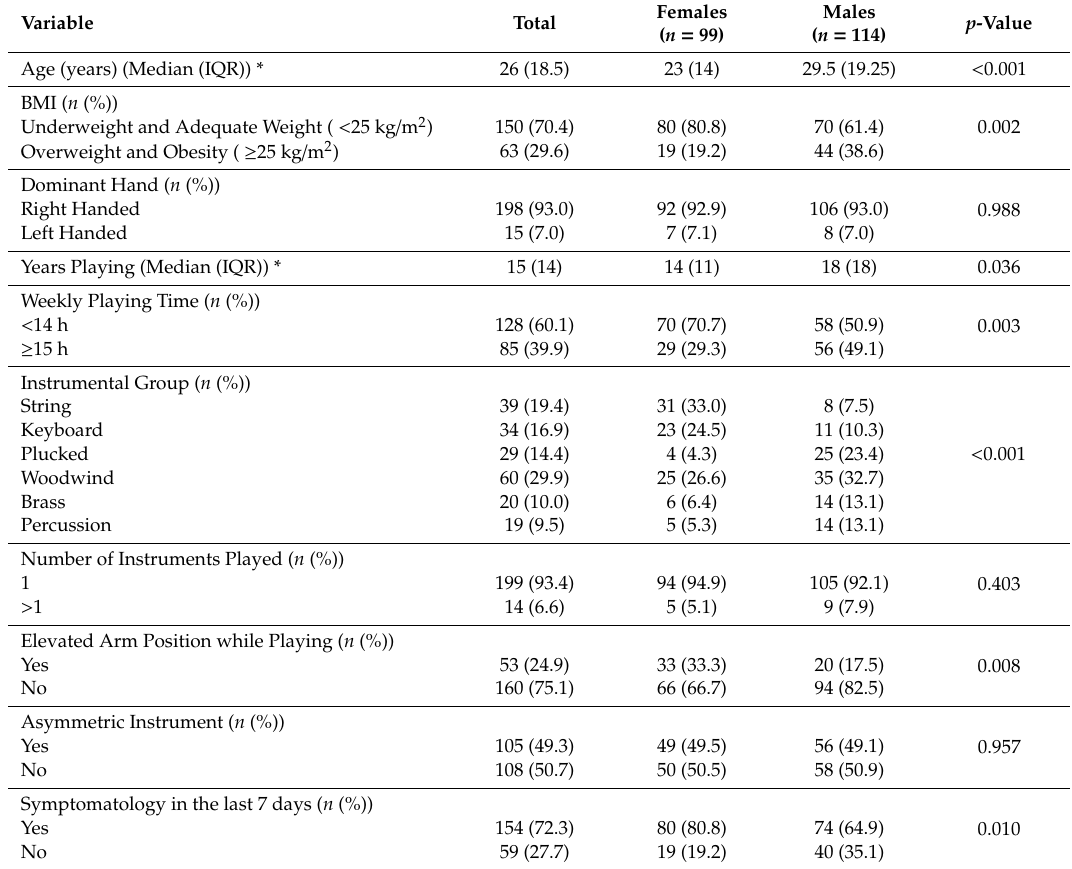
Table 1. Sociodemographic and instrumental practice data compared by gender ( n =